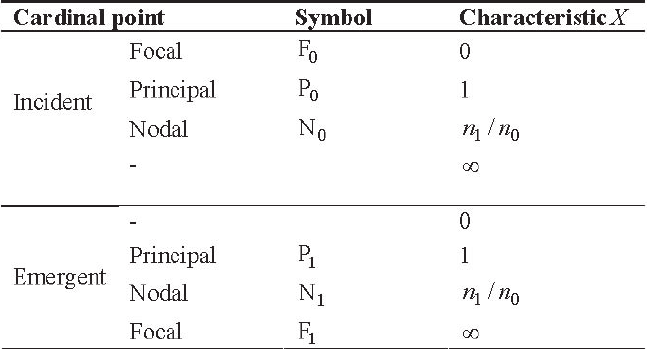
Table 1 Cardinal points and their characteristics X .